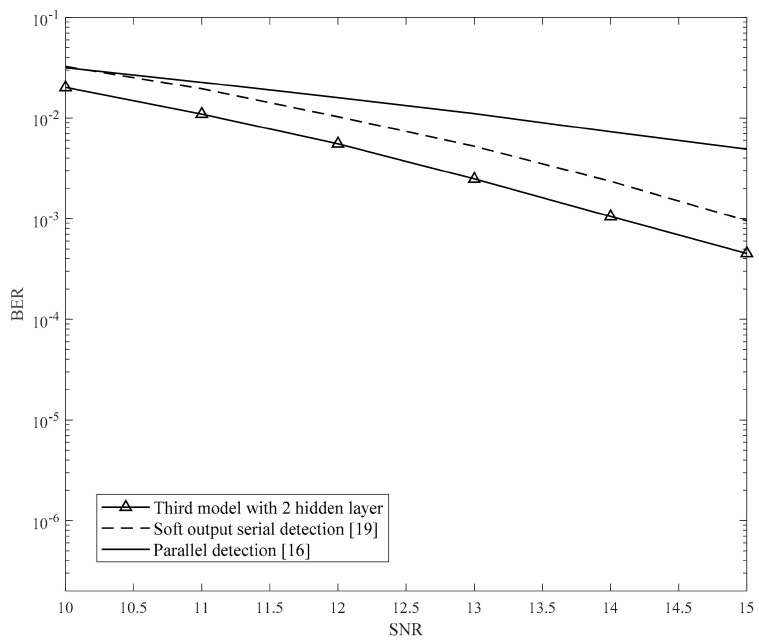
Figure 23. BER of the channel with 15% TMR and 8% position fluctuation.